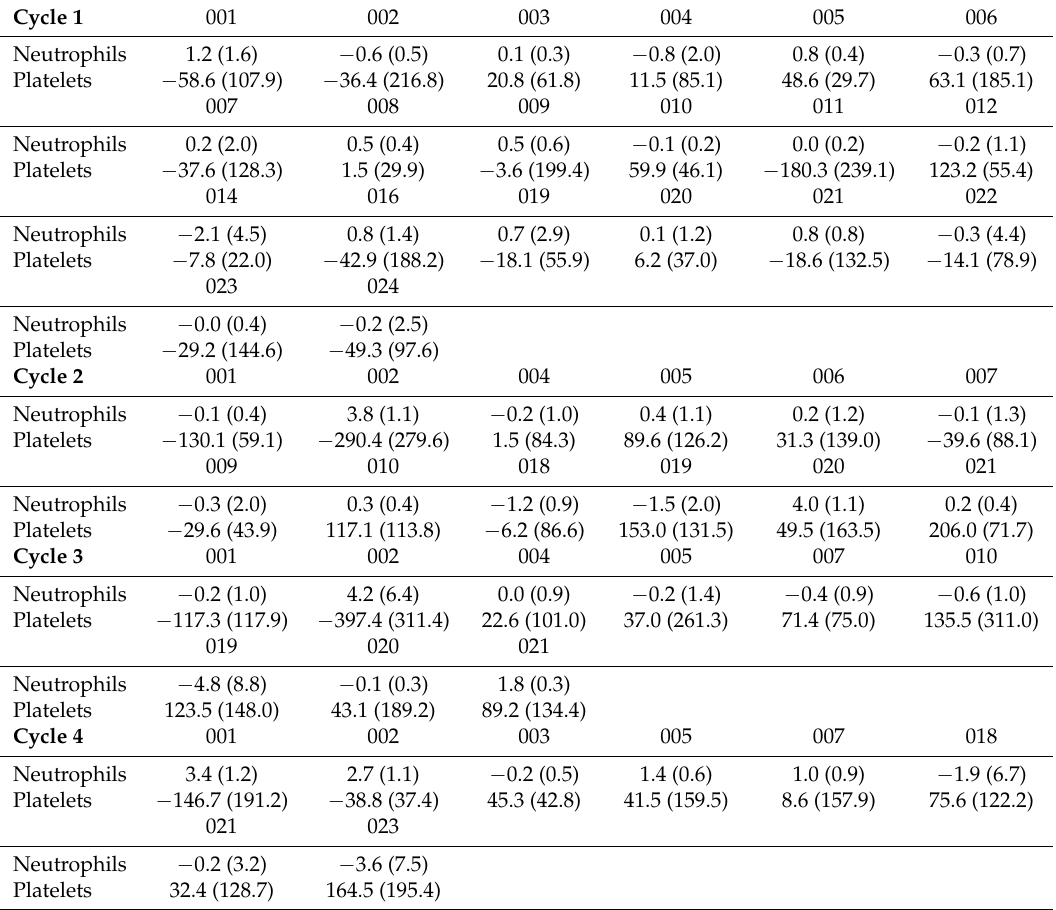
Table 4. The median value (over one cycle) of the error between prediction and observation for neutrophils and platelets levels for each patient that was not included in the dataset on which the regression model was trained and optimized. The value in parenthesis represents the median value of the interquartile